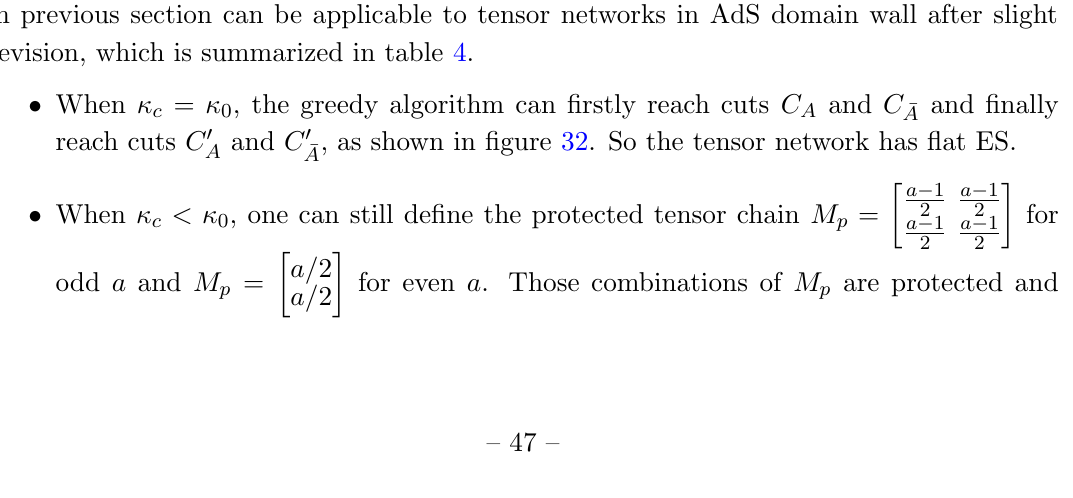
nh 1 i h 1 0 1 io ; , (c) S c = 2 1 1 1